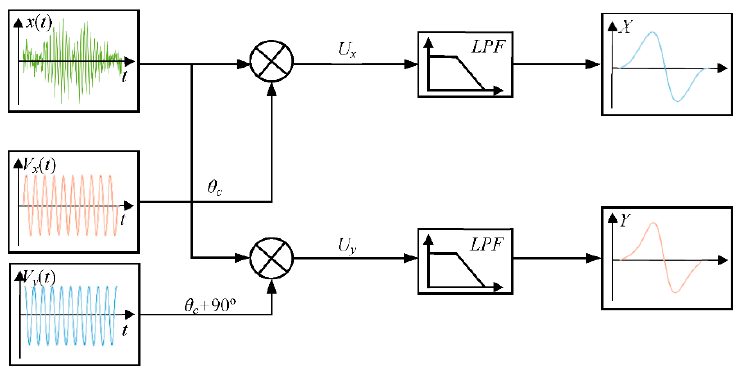
Figure 3. The quadrature demodulation process of the detection signal of balanced-field electromagnetic technique.